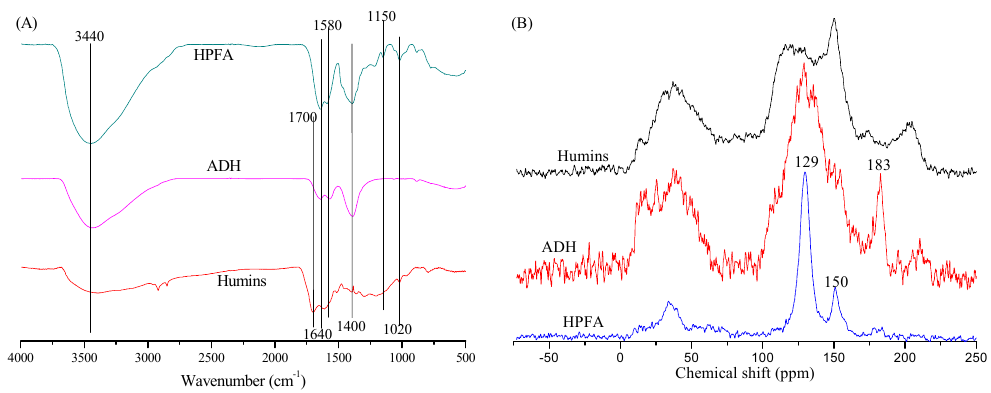
Figure 3. ( A ) FT-IR spectra of humins, cured ADH and HPFA; ( B ) C 13 NMR spectra of humins, cured ADH and cured HPFA.